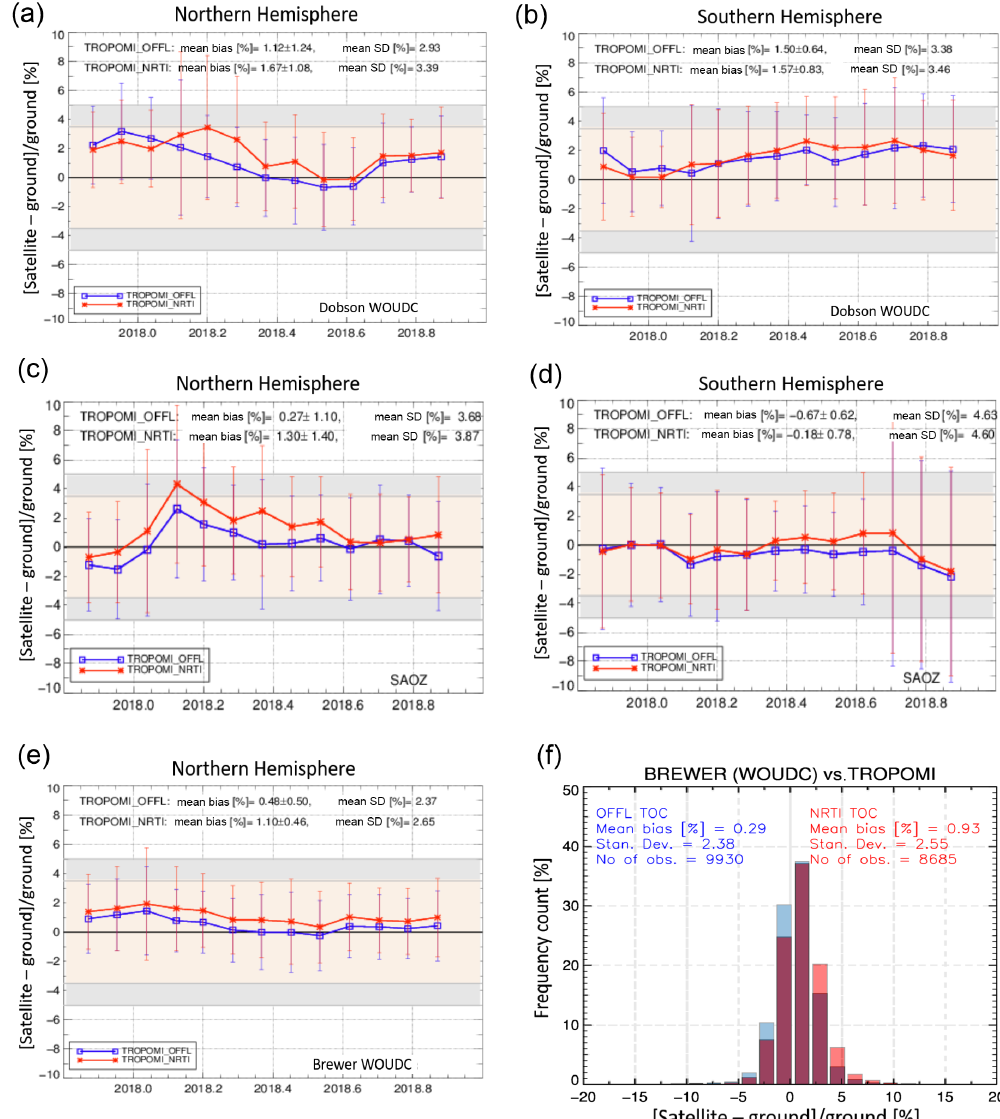
Figure 6. The monthly mean time series of the NRTI (red line) and the OFFL (blue line) TOC products of TROPOMI compared to Dobson GB measurements for the NH (a) and the SH (b) , SAOZ instruments ( c : NH, d : SH), and Brewer measurements for the NH only (e) . The error bars represent the 1 σ standard deviations of the monthly mean percentage differences. (f) The overall statistics of percentage differences between the two TOC products to the Brewer GB measurements are